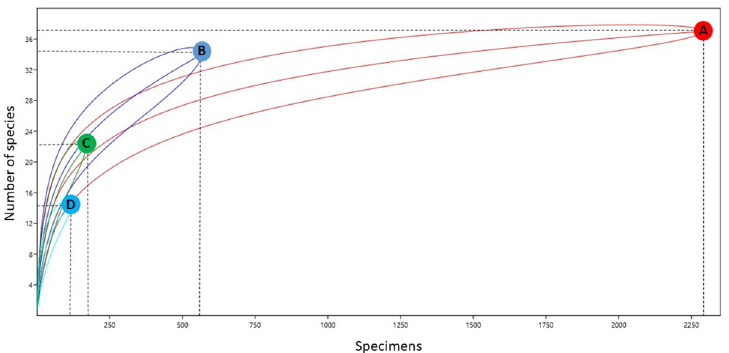
Fig 3. Rarefaction curves representing species richness of mosquitoes collected by vertical stratification. (A) HLC- ground; (B) HLC-canopy; (C) HP-ground; (D) HP-canopy.